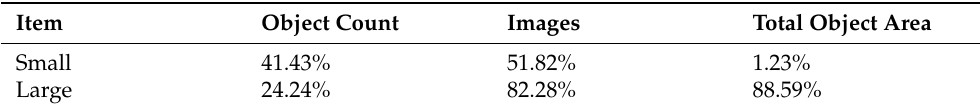
Table 2. The MS COCO dataset object statistics with respect to matched anchors in Mask R-CNN based on